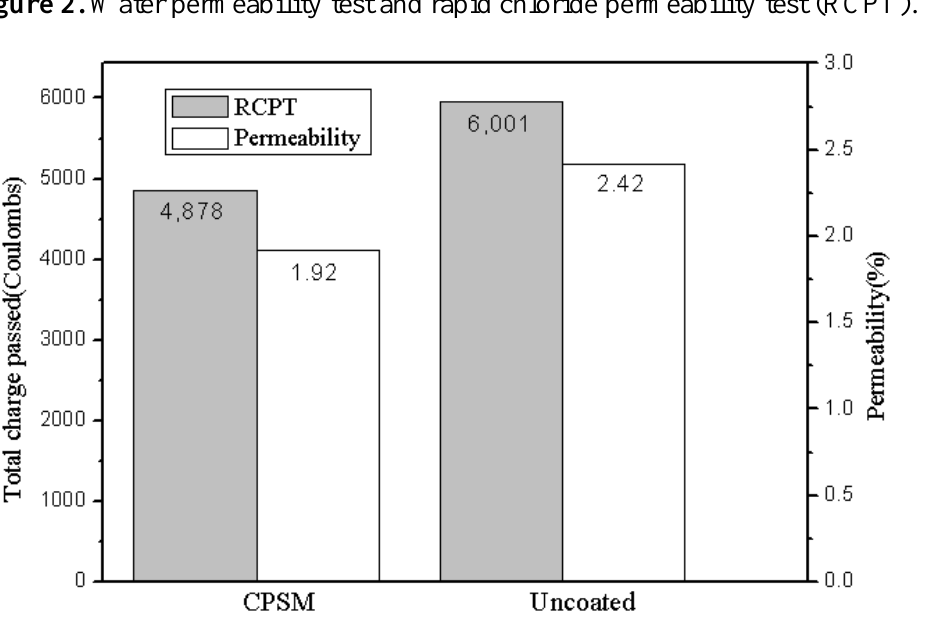
Figure 2. Water permeability test and rapid chloride permeability test